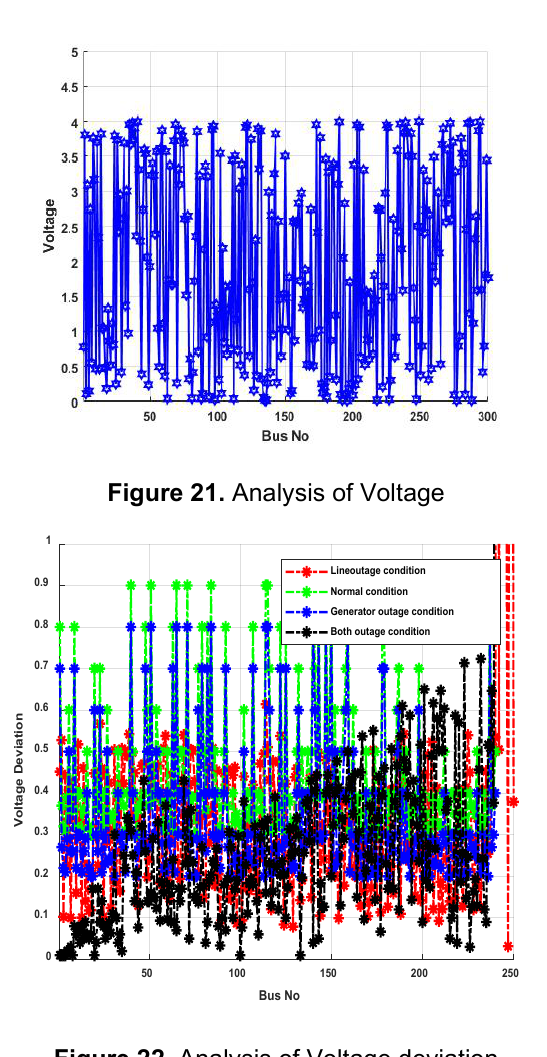
Figure 22. Analysis of Voltage deviation